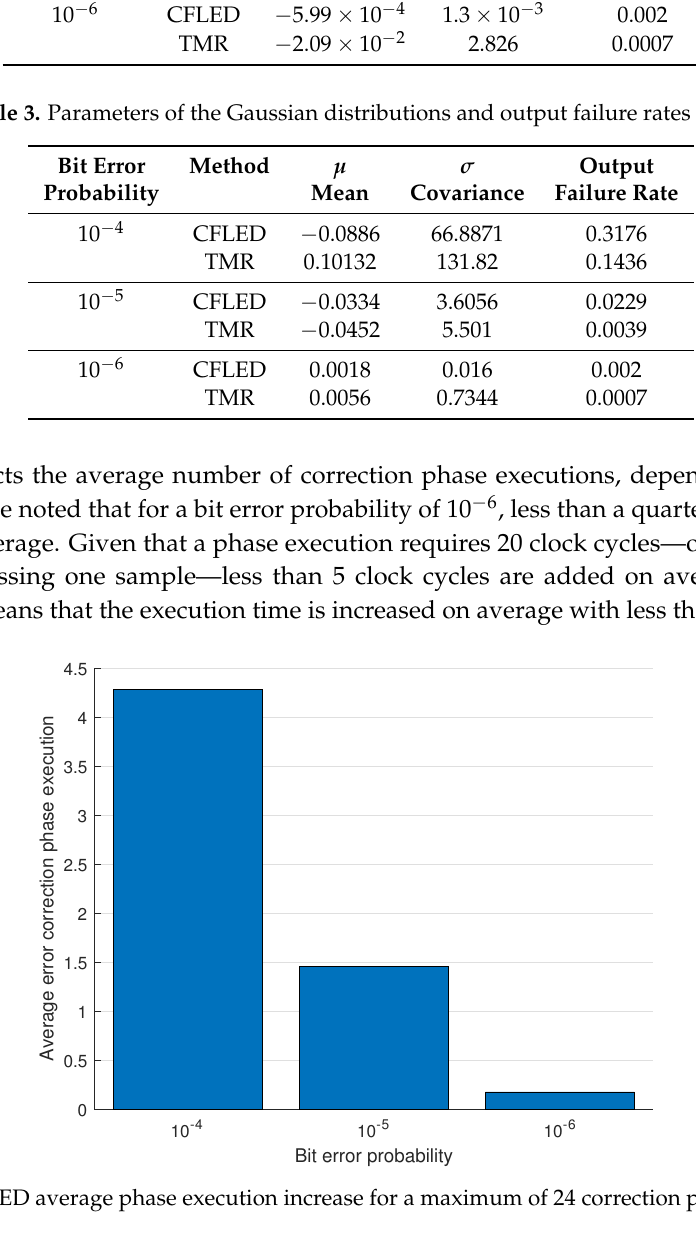
Table 3. Parameters of the Gaussian distributions and output failure rates for u r